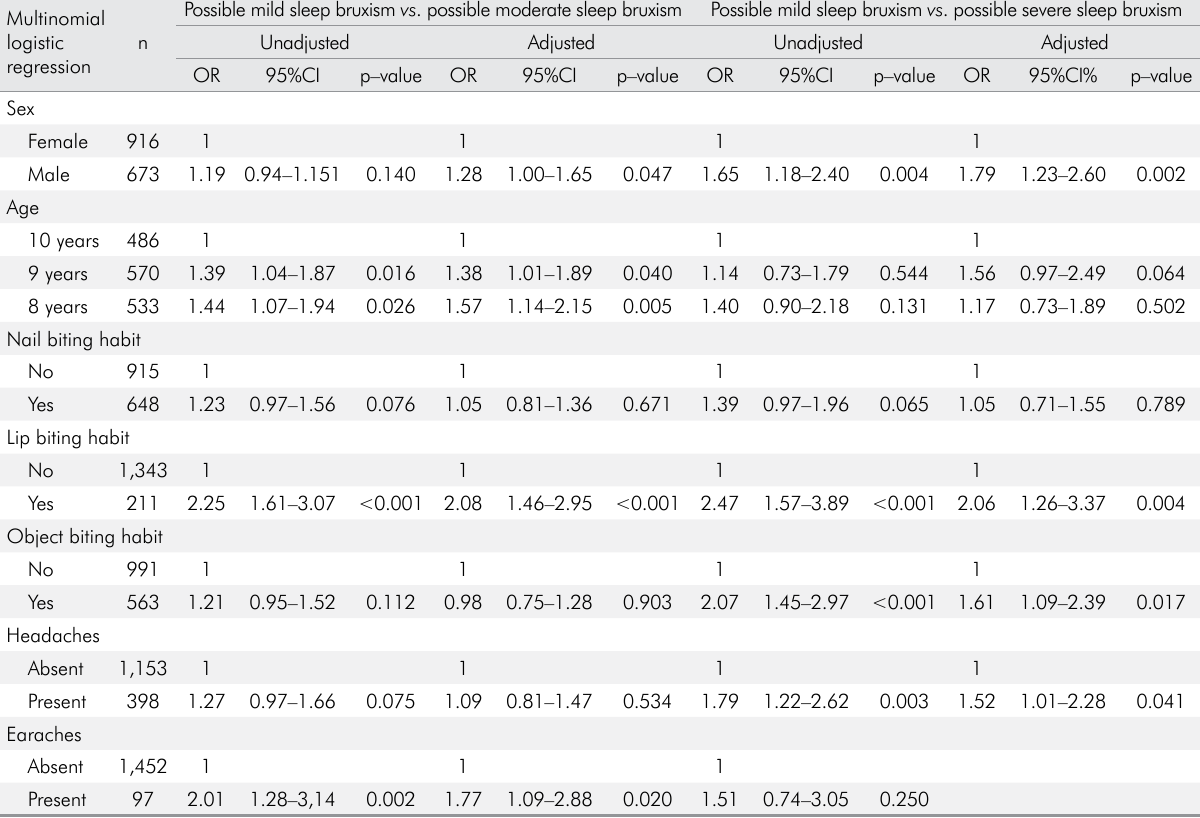
Table 2. Unadjusted and adjusted model by multinomial logistic regression showing the association of possible sleep bruxism (all degrees) with other independent